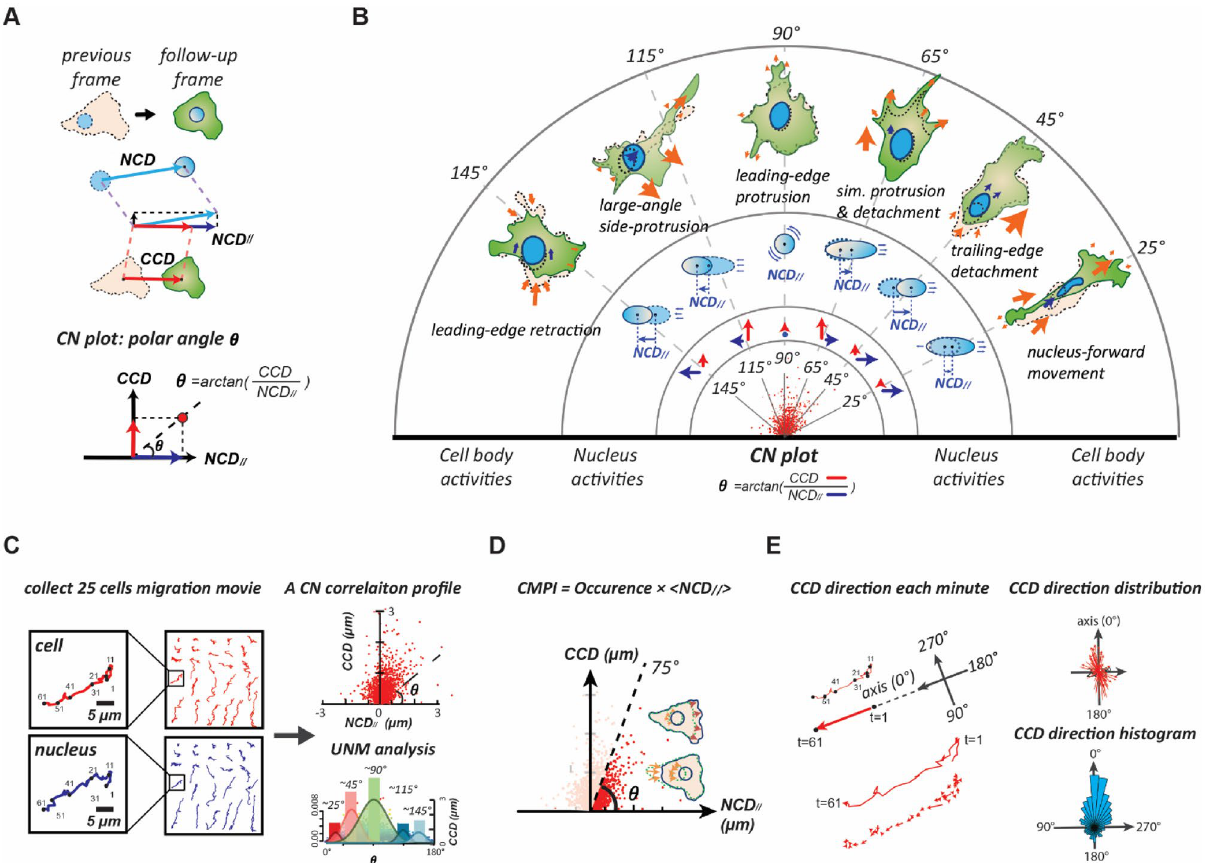
Figure 2. The overview of CN correlation analysis. ( A ) The framework of CN correlation analysis. ( B ) Six representative subcellular activities displaying their specific distributions in the CN plot. A signature CN polar angle represents a migratory pattern of the corresponding subcellular activity. ( C ) Illustration of the CN profile definition and the univariate normal mixtures (UNM) analysis. A CN correlation profile (n = 1500) is constructed using a collection of 25 randomly selected, one-hour movies of NIH fibroblasts at one-minute intervals. The UNM analysis is applied to profile the composition of normal distribution curves that describe the signature migration patterns and the proportions of the corresponding subcellular activities. ( D ) The schematic of the cell migration. Occurrence denotes the frequency rate of the CN correlations over populations located in the region (0°–75°); < NCD // > represents the mean value of NCD // over the population. ( E ) Methodology schematic for the migration polarity analysis of the cell. One-minute CCD direction is aligned with the orientation of one-hour displacement. The direction histogram reveals migratory